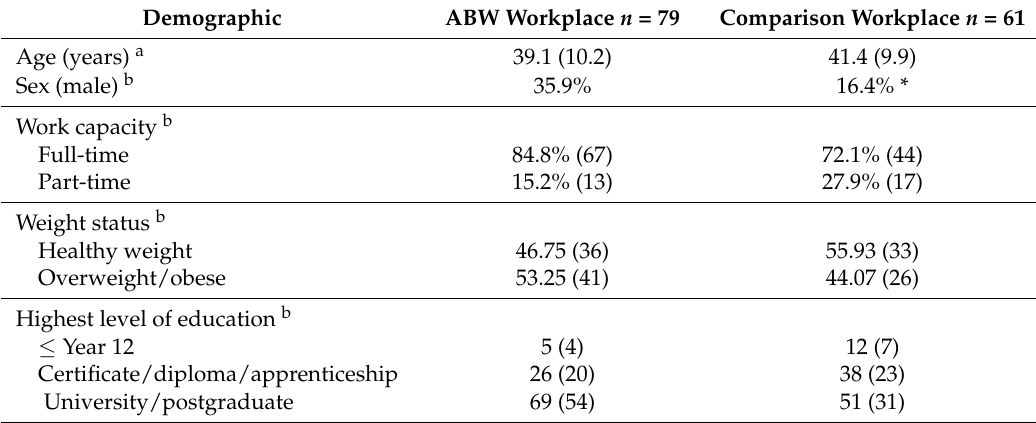
Table 1. Participant demographics at